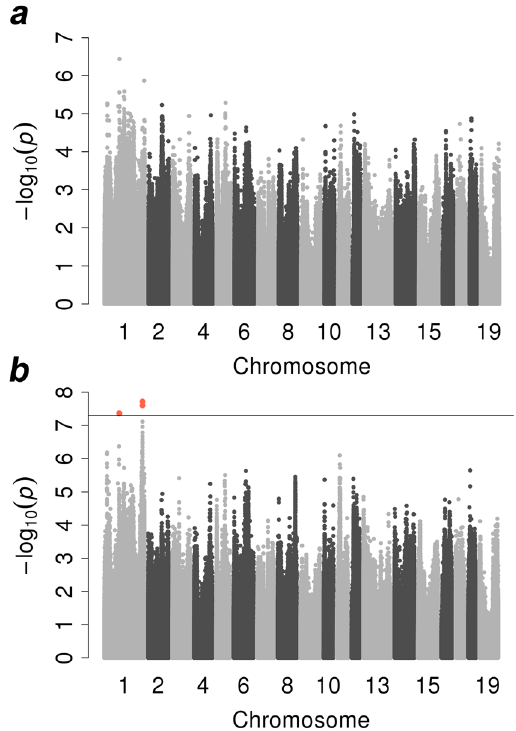
Figure 4. GWAS results for lumbar number in two scenarios: conditional test and LD drop test. ( a , b ) Manhattan plots for lumbar number in the conditional association test and LD drop association test, respectively. In the Manhattan plots, the y-axis and x-axis represent the negative log 10 P values of the SNPs and the genomic positions separated by chromosomes, respectively. In Manhattan plots a and b, the black solid lines indicate the chromosome-wide significance threshold ( − log10(5E-08)), and in ( b ), the tomato puree points represent SNPs that exceeded the chromosome-wide significance